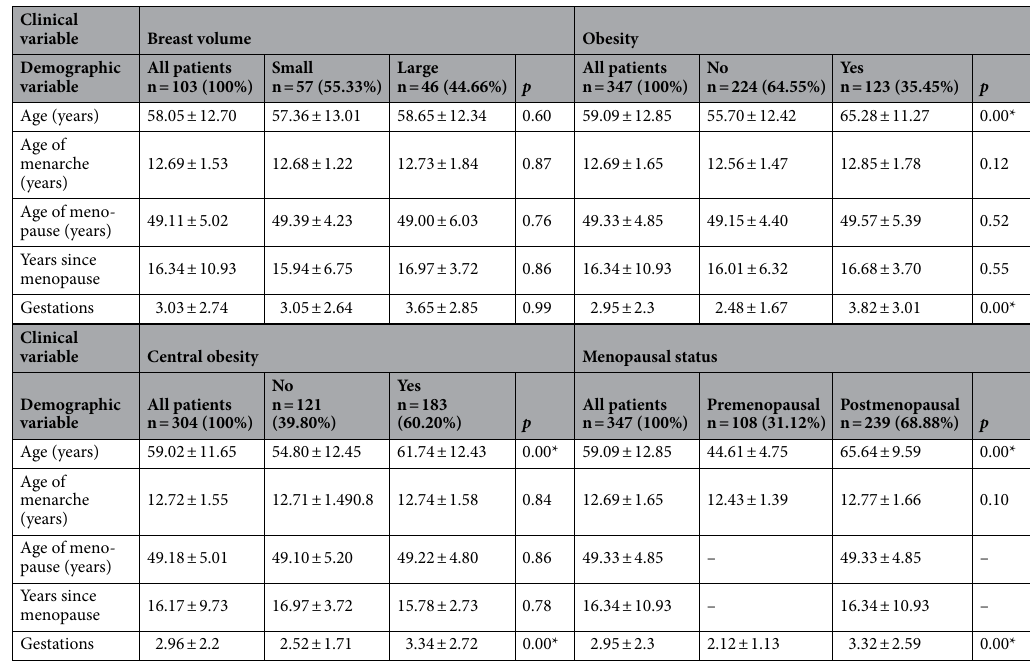
Table 1. Demographic characteristics of patients with breast cancer according to their breast volume (small vs. large), BMI (obesity vs. non-obesity), central obesity (WHR < 0.85 vs. WHR ≥ 0.85) and hormonal status (premenopausal vs. postmenopausal). n = number of cases assessed for each variable. Data expressed as means ± standard deviation. * p < 0.05.